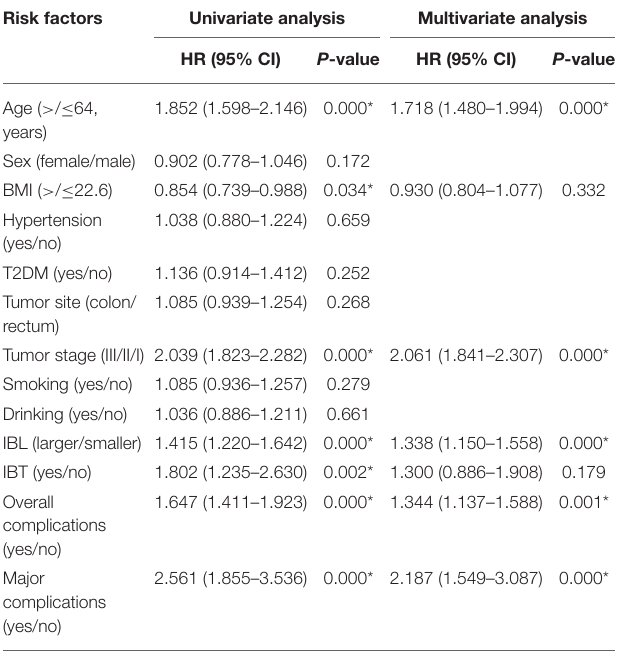
TABLE 7 | Univariate and multivariate analysis of overall survival. Risk factors Univariate analysis Multivariate analysis